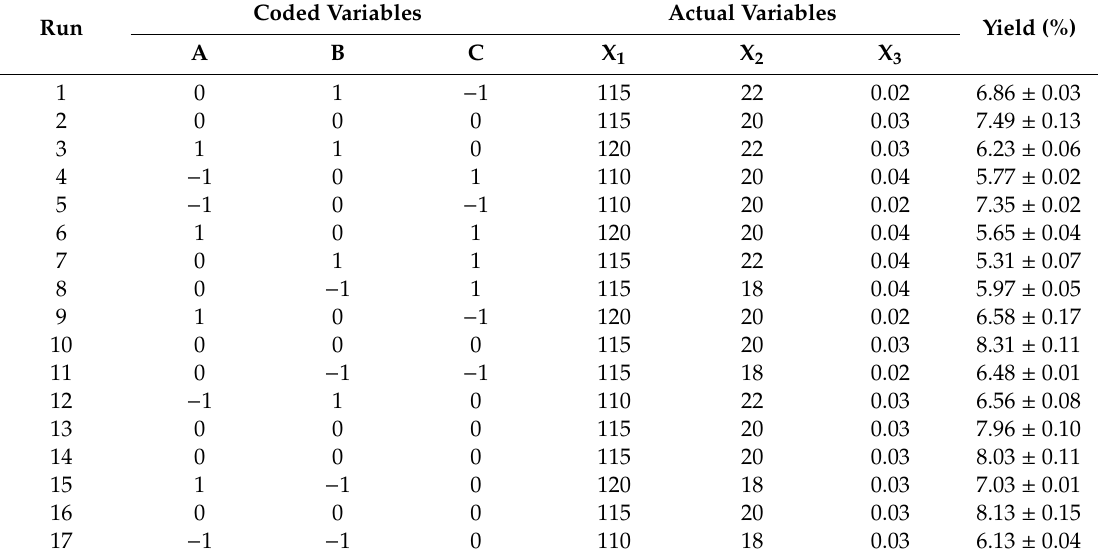
Table 1. Drying response surface analysis test design and results (each test was done 3 times).